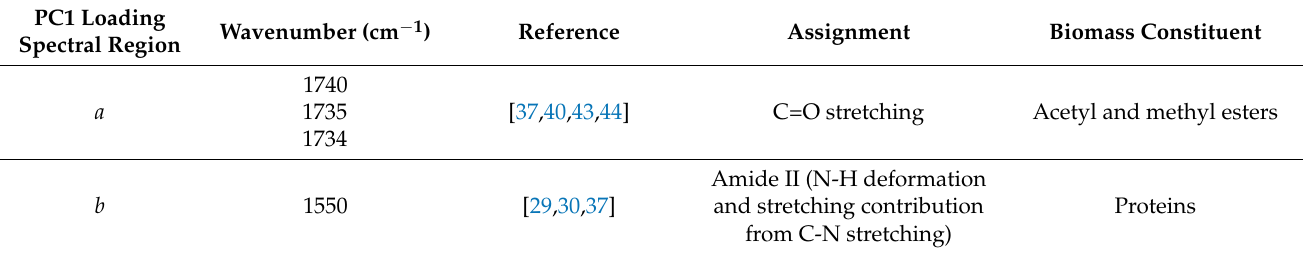
Table 2. Assignment of relevant FTIR-ATR absorption bands characteristic of maize cell wall